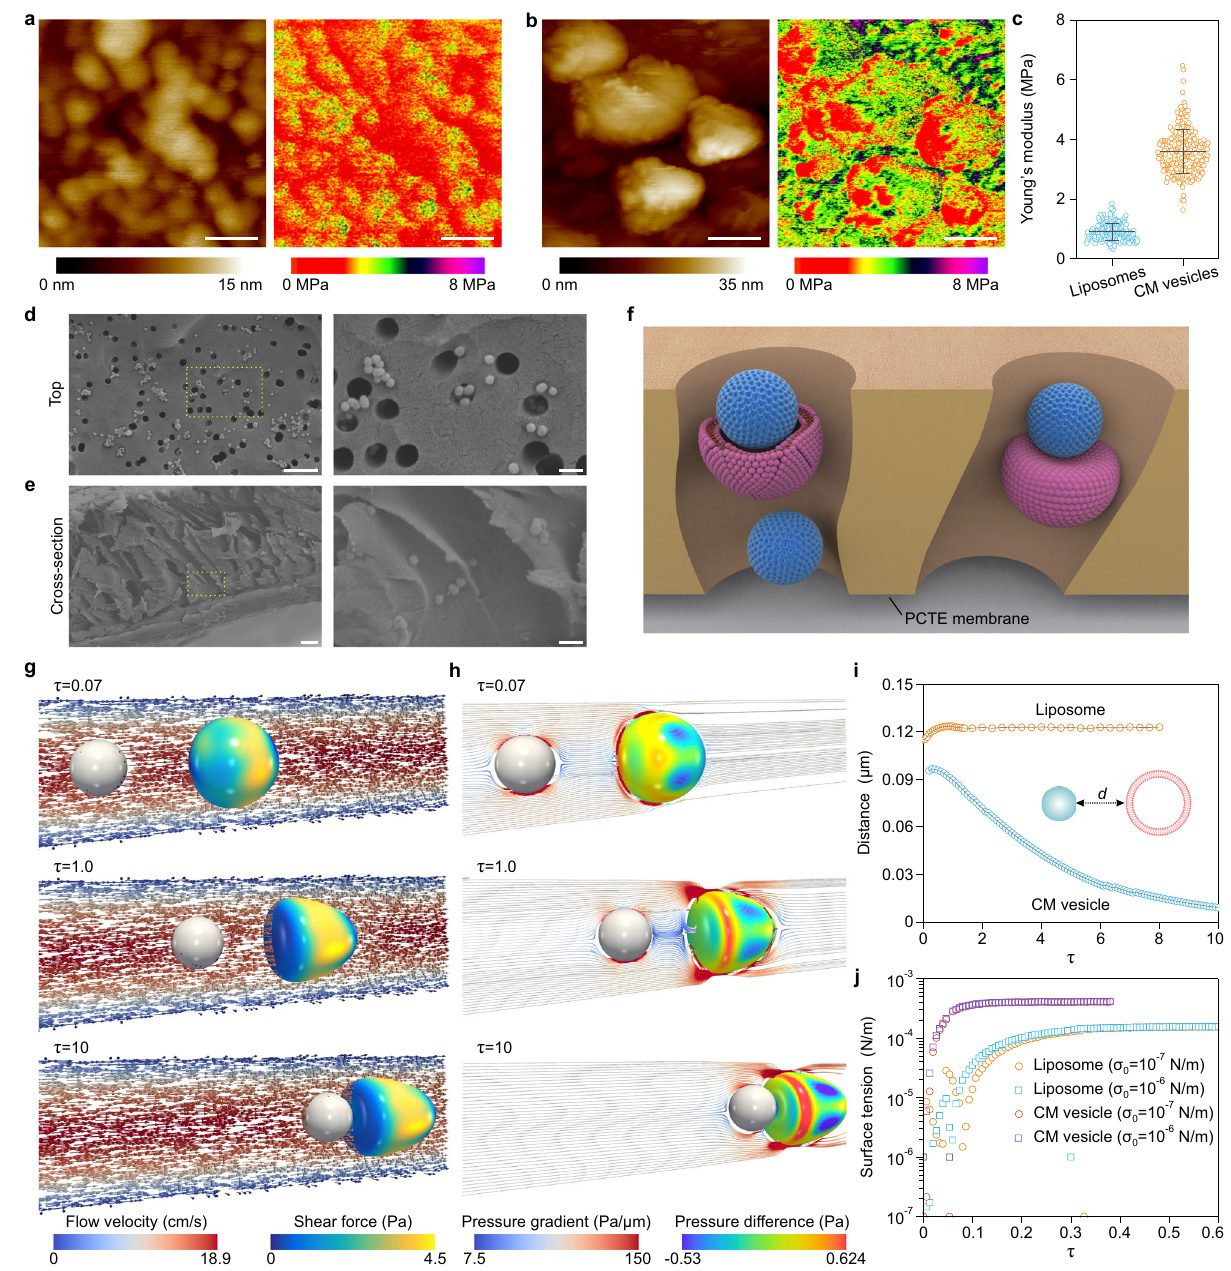
Fig. 2 | Computational modeling of the interaction between CM vesicles and SiO 2 NPsduringextrusion.a , b AFMtopographicimages(leftpanel)ofliposomes ( a ) and CM vesicles ( b ), along with the corresponding Derjaguin – Muller – Toporov Young ’ s modulus map (right panel). Scale bars, 50nm. c Quanti fi cation of the average Young ’ s modulus of liposomes ( n =212 positions from 10 independent liposomes) and CM vesicles ( n =229 positions from 10 independent CM vesicles). Data represent the mean±s.d. d , e SEM images of polycarbonate track-etched (PCTE)membraneafterextrusionintopview( d )andcross-sectionalview( e ).Scale bars,1 µ minlow-magni fi cation(leftpanel)and200nminhigh-magni fi cation(right panel). f SchematicillustrationoftheinteractionbetweenCMvesiclesandSiO 2 NPs in theporeof PCTEmembrane duringextrusion. g , h Time evolutionofCMvesicle deformation and positions with times taken as: τ =0.07, τ =1.0, and τ =10. g Distribution of the shear force along the surface of CM vesicle with the